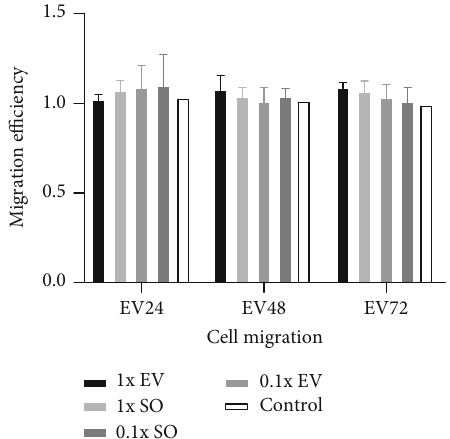
Figure 3: Cell migration e ffi ciency of FNA-BMSCs induced by di ff erent EV groups, relative to controls. No signi fi cant di ff erences were observed between groups. All of the data are presented as mean ± SD